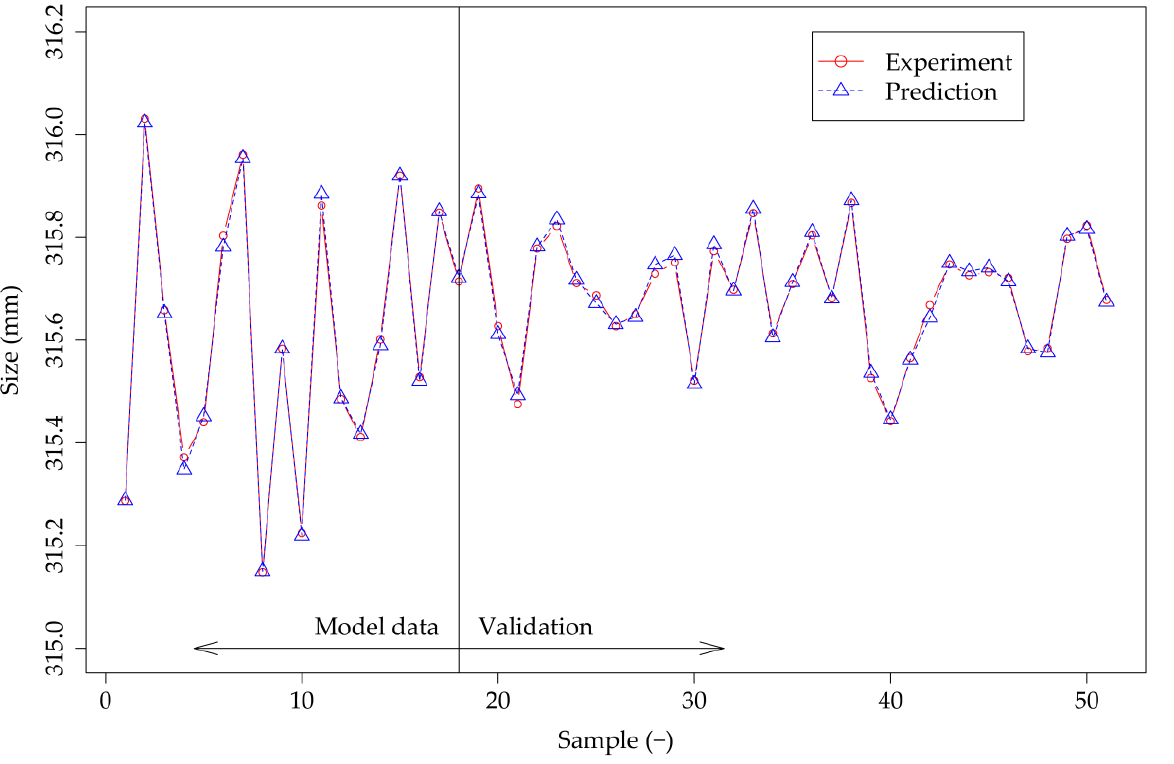
Figure 4. Comparison between prediction and experimental data for LR.